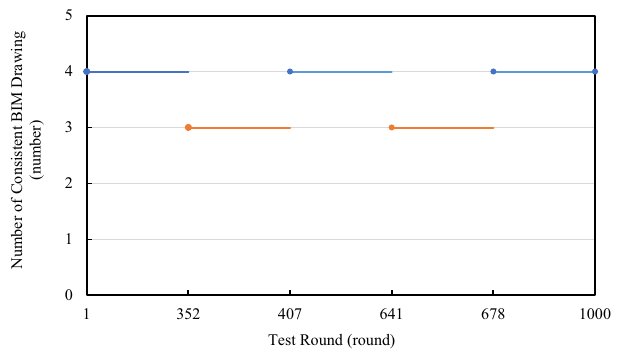
Figure 15. BIM drawing